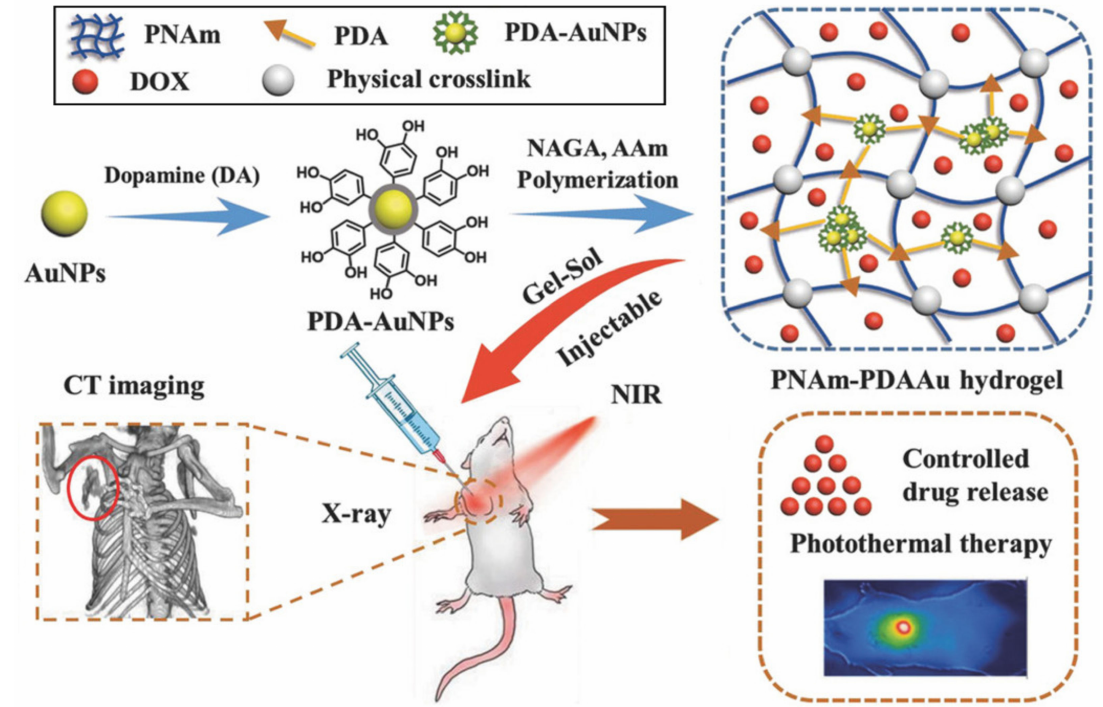
Figure 10. Schematic illustration of the fabrication of PNAm-PDAAu nanocomposite hydrogel and its application as a cancerous breast filler with simultaneous self-imaging and therapeutic functions. Adapted with permission from Ref.